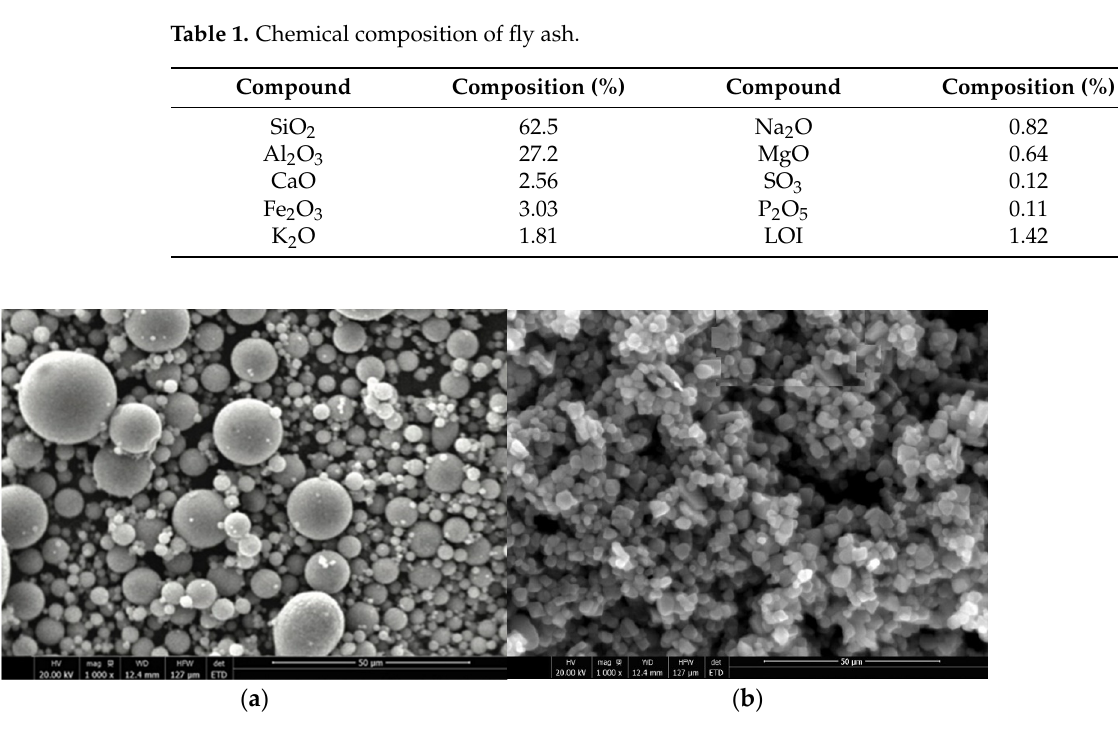
Figure 1. SEM micrographs of ( a ) fly ash and ( b ) NS.